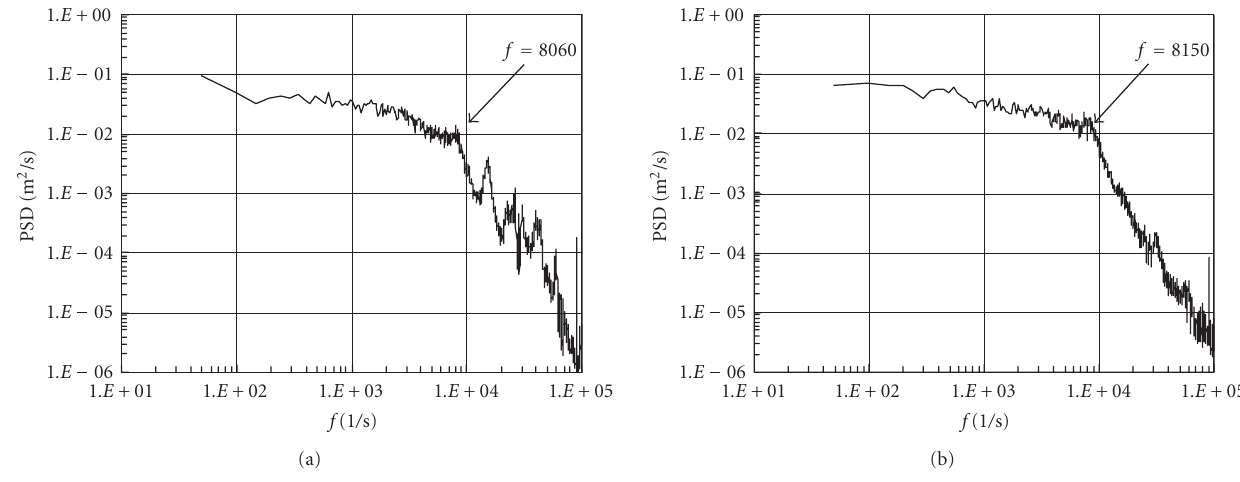
Figure 10: Power spectra density profiles measured in the pressure side wake at y/cx = 0 . 10 one axial chord length downstream of the cambered airfoil with big-sized roughness and ks/cx = 0 . 00258. (a) Tu = 1 . 1 percent. (b) Tu = 7 . 7 percent.